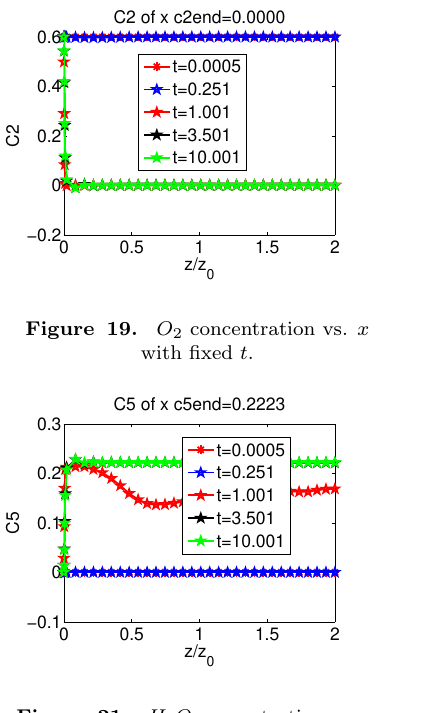
Figure 22. Propane C 3 H 8 concentration vs. x with fixed t